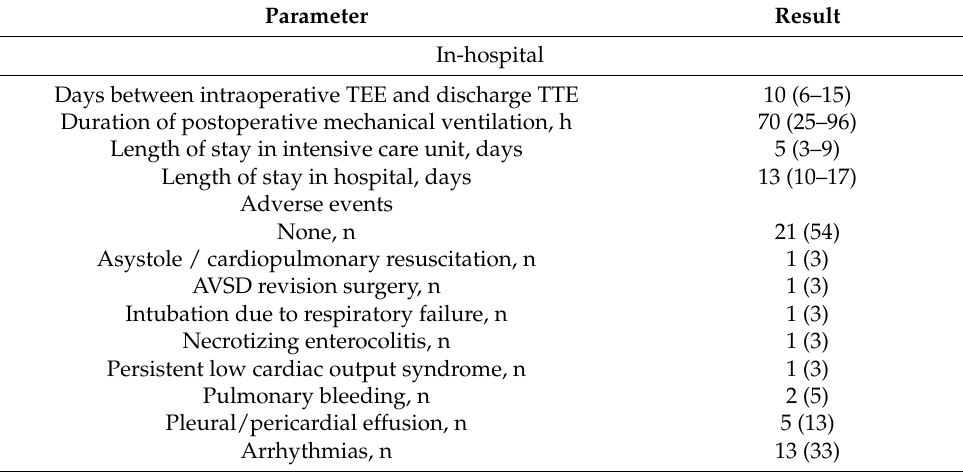
Table 4. Postoperative